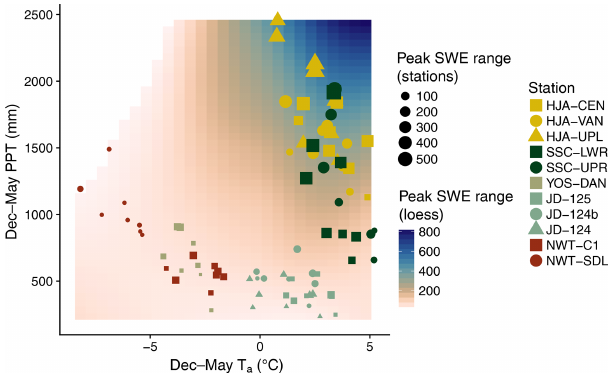
Figure 12. Range in annual peak SWE as simulated by the differ- ent precipitation phase methods at the 11 study stations. Each point represents one simulation year at a given station, and larger points correspond to larger differences in maximum minus minimum peak SWE. The background shading corresponds to ranges in peak SWE predicted by a loess function fit to the station